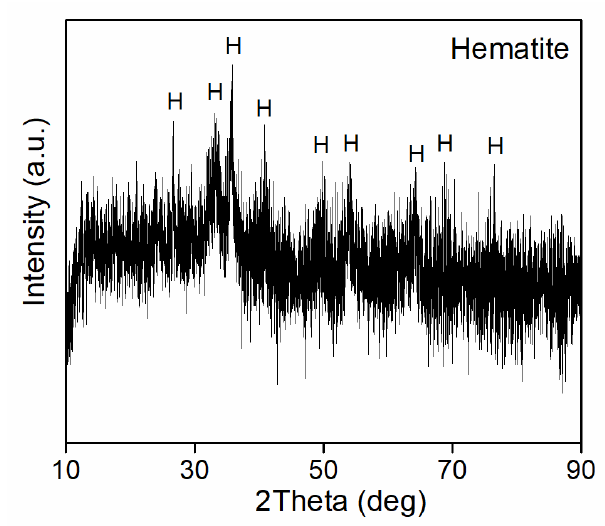
Figure A5. XRD result for natural hematite. Hematite (H) and quartz (Q) were identified.